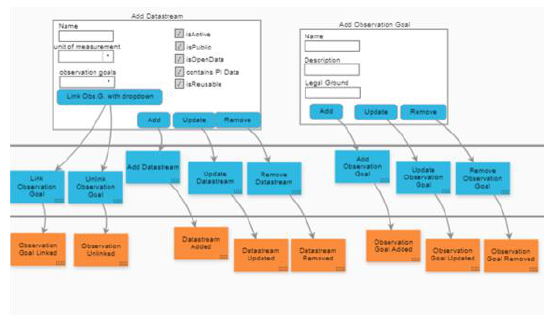
Figure 7 . Eventmodeling of Datastream and Observation